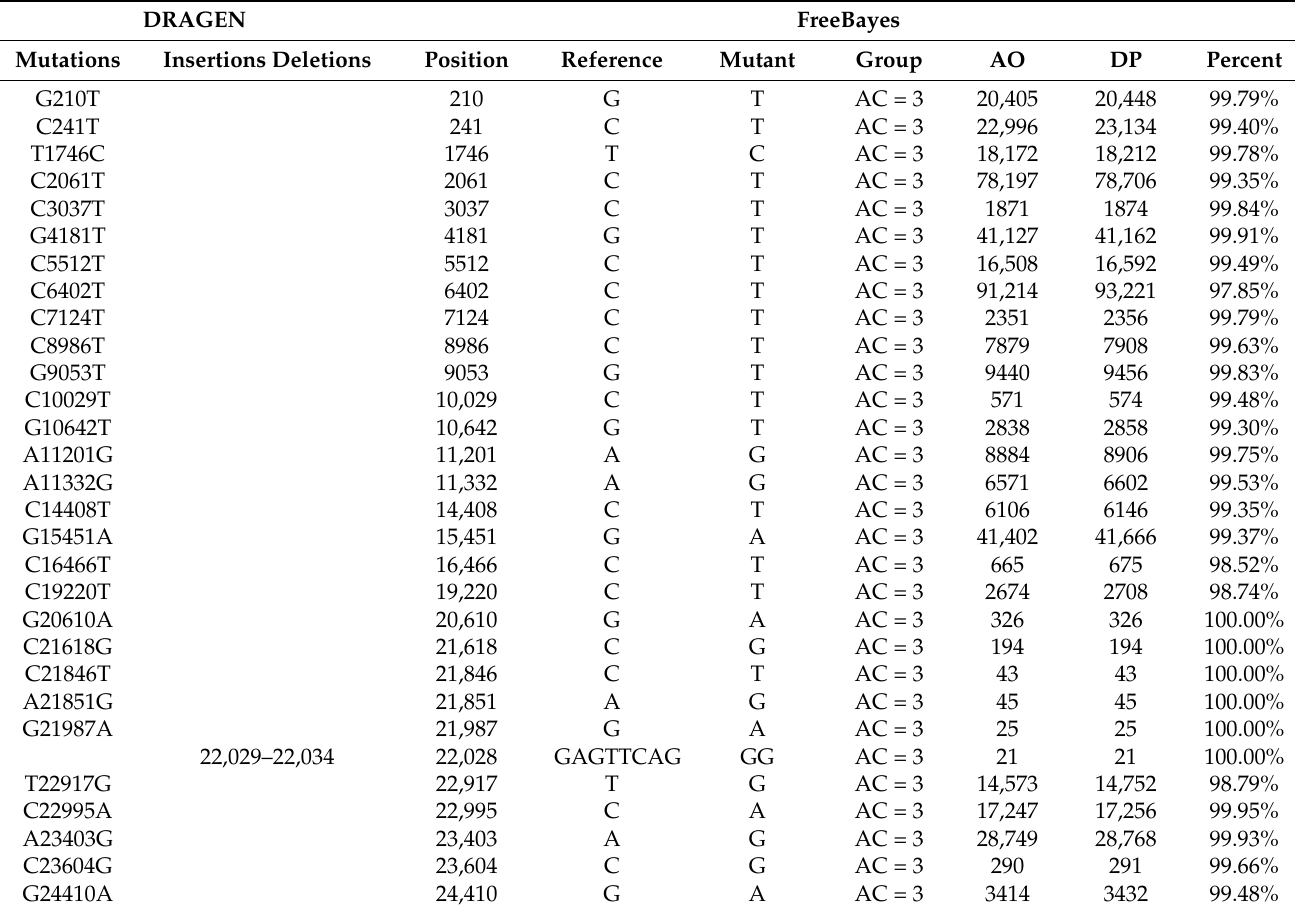
Table 2. Mutations present in sample